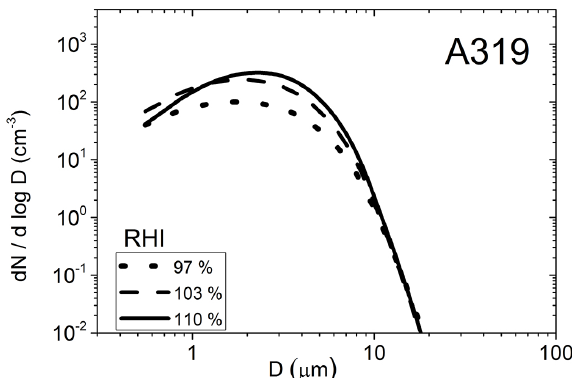
Fig. 7. Particle number concentrations for ambient RHI of 97/103/110%, respectively. The simulations were performed with the EULAG-LCM model for the A319 aircraft. All parameters but RHI were kept constant. While the total particle number increases for higher RHI, no significant concentration increase is observed for large particles. The increase in particle number density with in- creasing RHI for diameters within 1µm to 10µm leads to higher values in extinction and optical